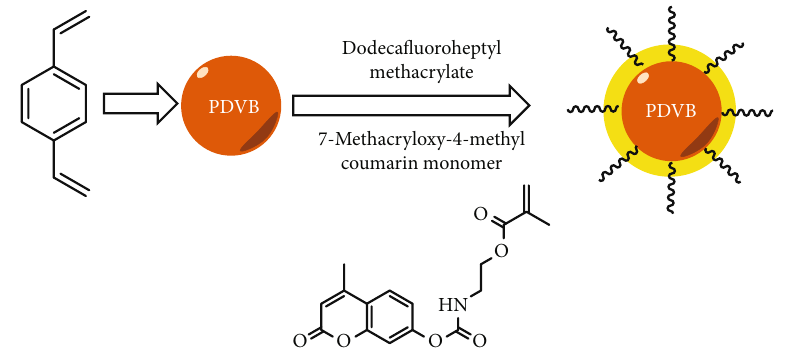
Scheme 1: Synthesis of the polymer microsphere.